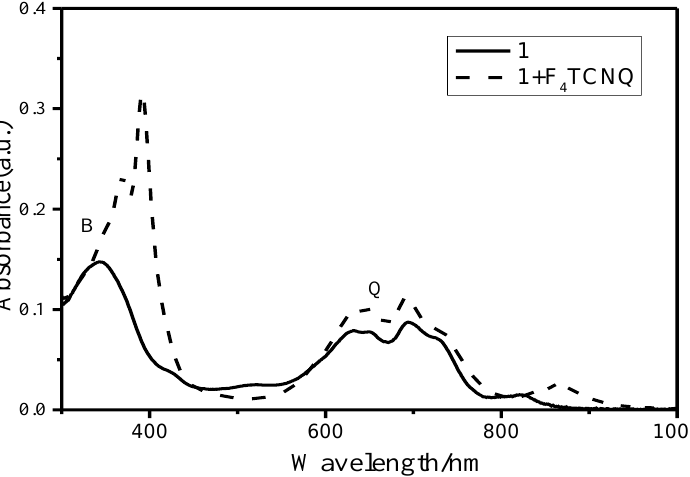
Figure 3. Absorption spectra of 1 in CH 2 Cl 2 (1 × 10 − 5 M) with and without the addition of F 4 TCNQ (1 equiv).